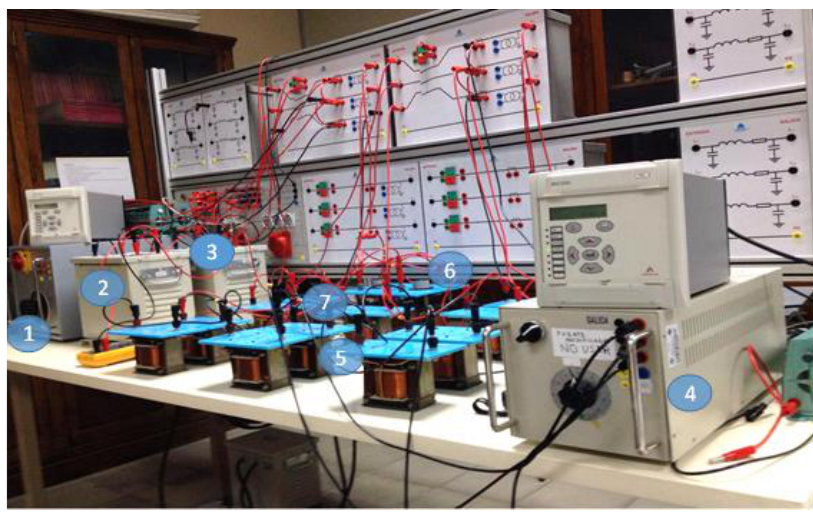
Figure 12. Laboratory circuit to simulate a section fed by a 2 × 25 kV system with two conductors and ground return. A fault between the catenary and rail in subsection A is represented.